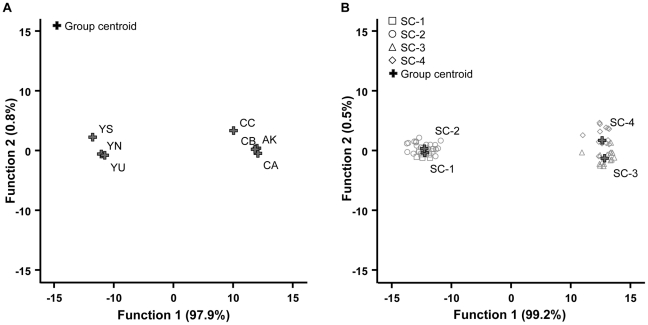
Chemical differentiation between the seven populations (A) and the four supercolonies (B).The differentiation is illustrated by a factor map of the two first axes of the canonical discriminant analysis on the relative proportions of cuticular lipids. Functions one and two account for 98.7% and 99.7% of the total variability among populations and supercolonies, respectively. Only group centroids are plotted on figure A. P. megacephala var. 1: populations YM, YN, YS, YU and supercolonies SC-1, SC2; P. megacephala var. 2: populations AK, CA, CB, CC and supercolonies SC-3, SC-4.